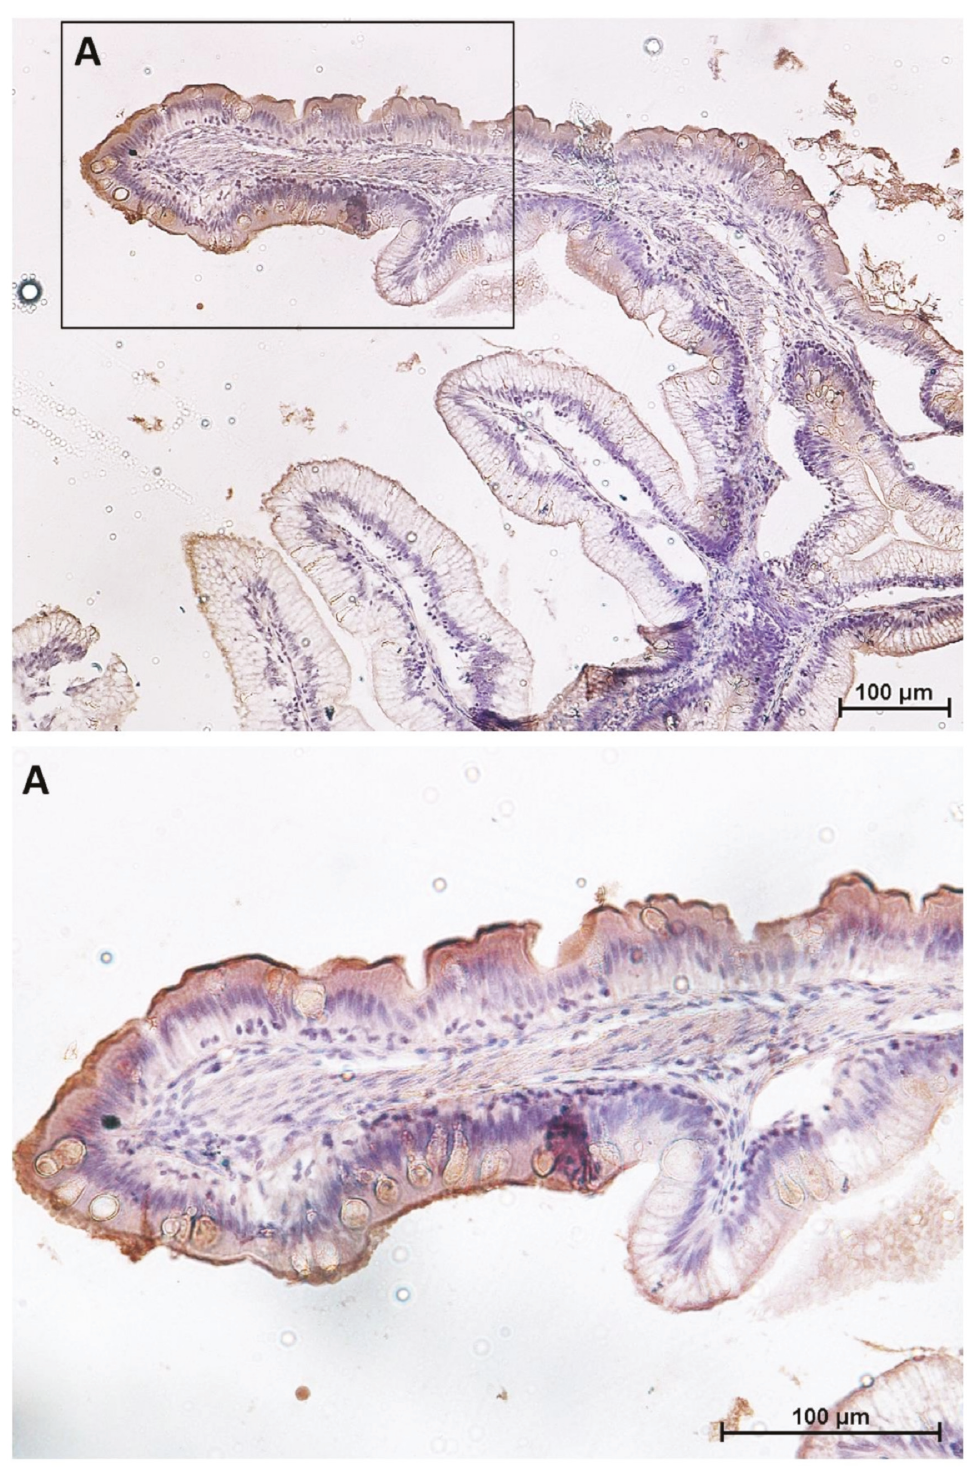
Figure 5. Immunolocalization of sodium–glucose / galactose transporter 1 (SGLT1) in the second segment of the mid-intestine. SGLT1 expression is confined to the apical portion of the complex folds where it shows the same location and signal intensity found in the first segment of the mid-intestine. The lower panel shows ( A ) at higher magnification.